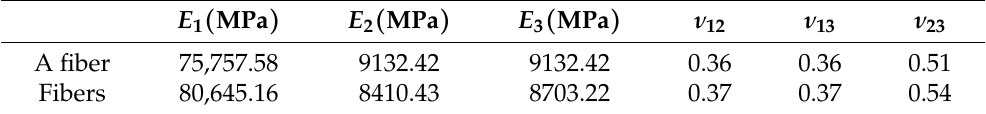
Table 2. Material properties of RVE in homogenization.